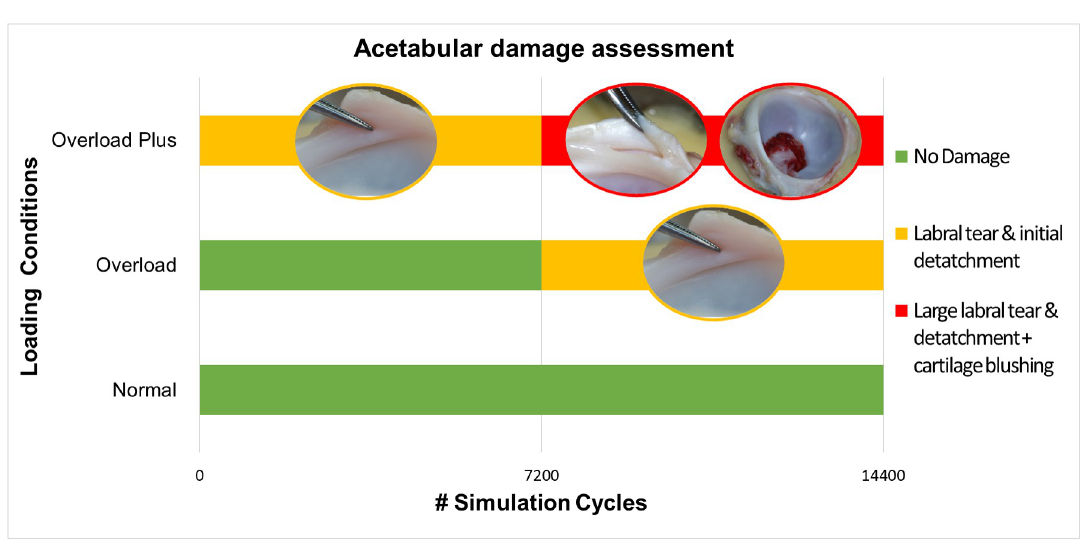
Fig 12. Acetabular damage assessment. Summary of the damage presented for the different loading